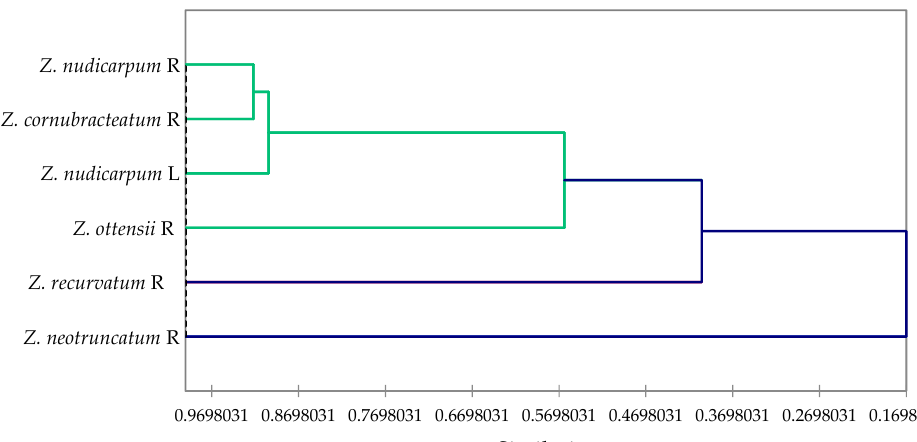
Figure 3. Dendrogram obtained from agglomerative hierarchical cluster analysis of the Zingiber essential oils screened for larvicidal activity.